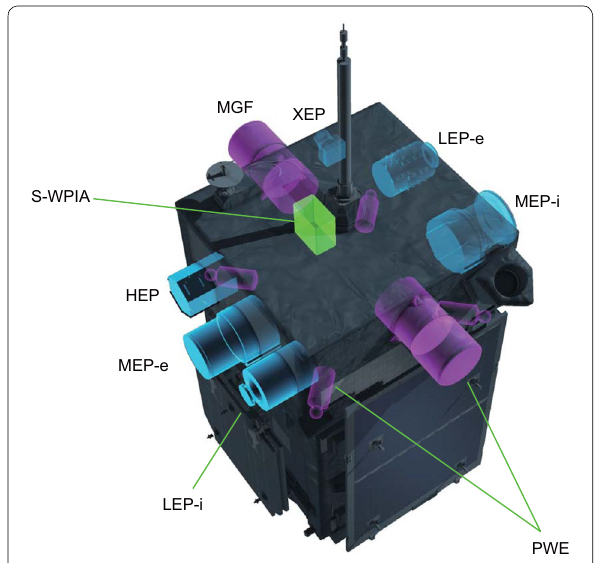
Fig. 4 Configuration of science instruments onboard the ERG satellite